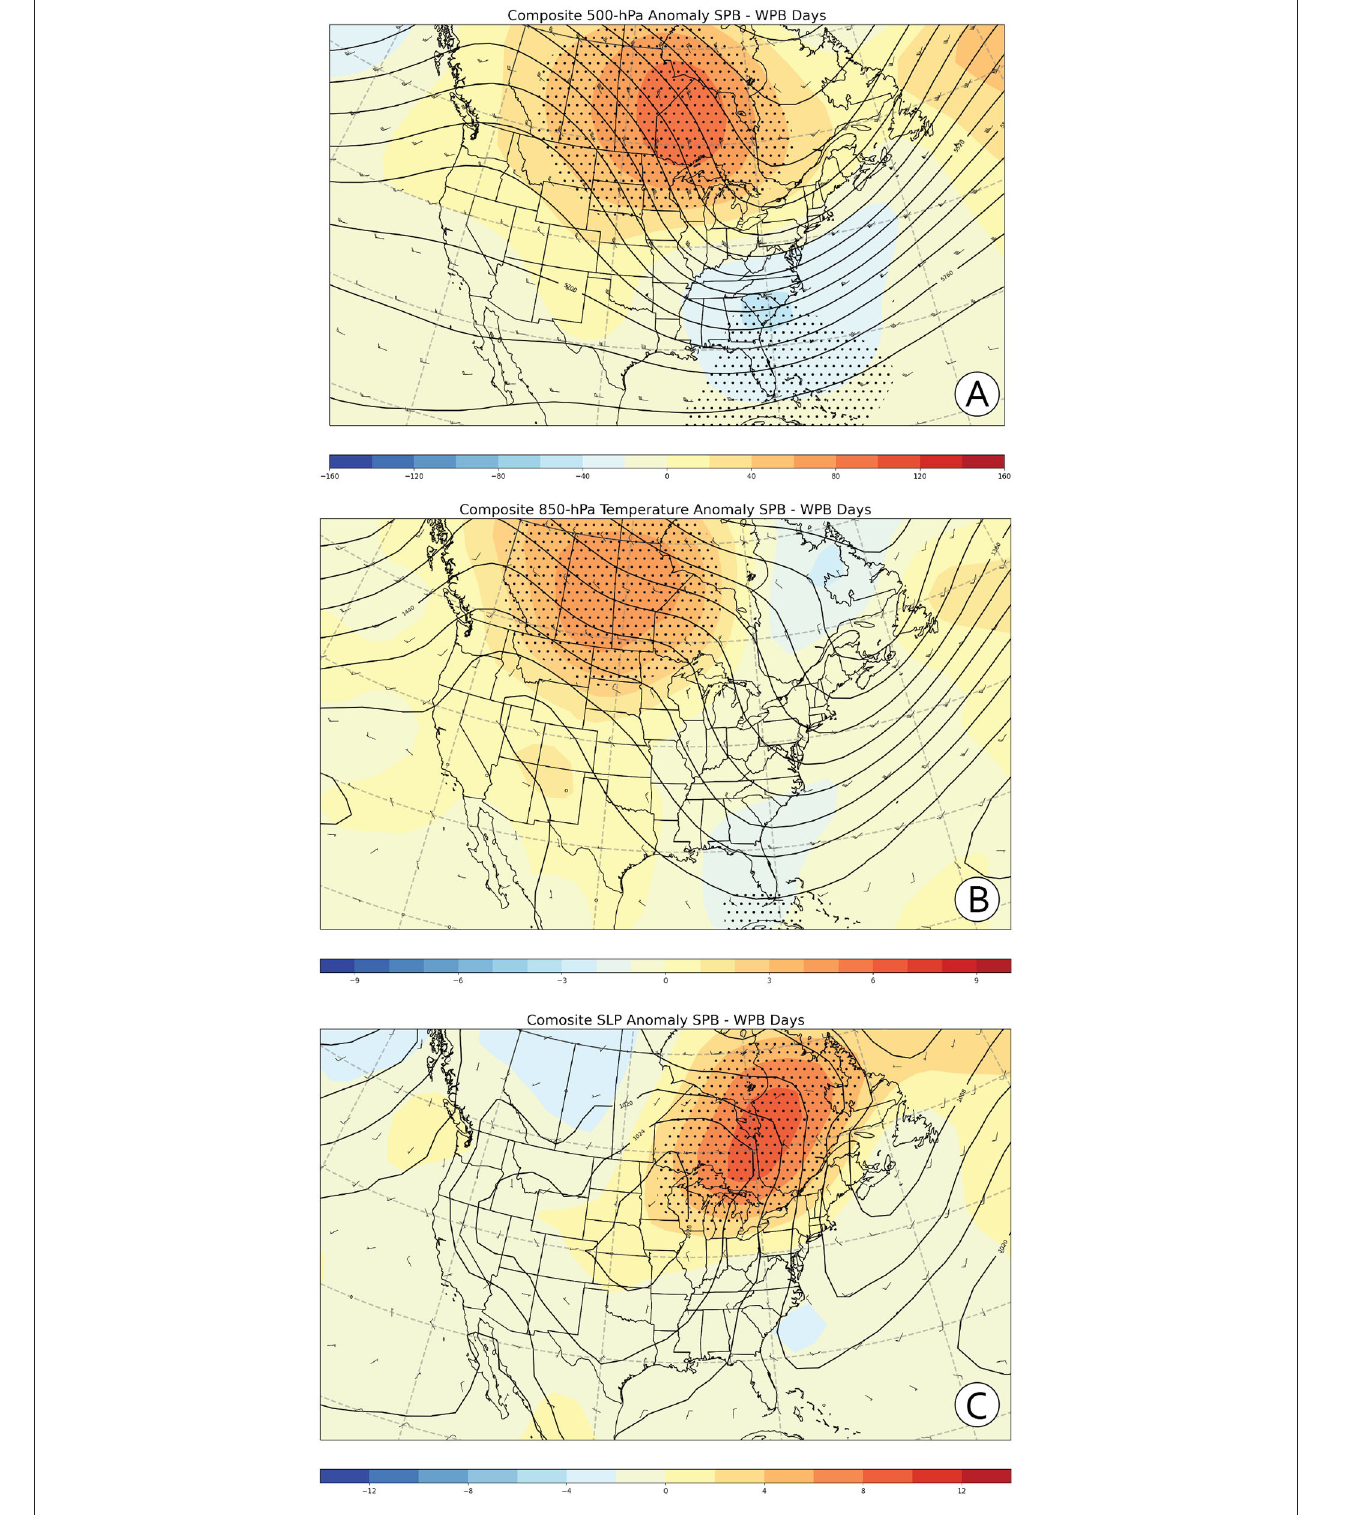
FIGURE 5 | Composite 12 UTC Reanalysis I (A) 500-hPa geopotential height (upper), (B) 850-hPa temperature (middle) and (C) sea-level pressure (lower) differences between days with SPB and WPB cloud classifications. Differences are indicated by filled and solid contours. Dots indicate regions for which the null hypothesis of equal mean SPB and WPB 500-hPa geopotential height, 850-hPa temperature and sea-level pressure can be rejected, respectively. This assessment is based on bootstrap simulations using 10,000 50-member sub-samples.